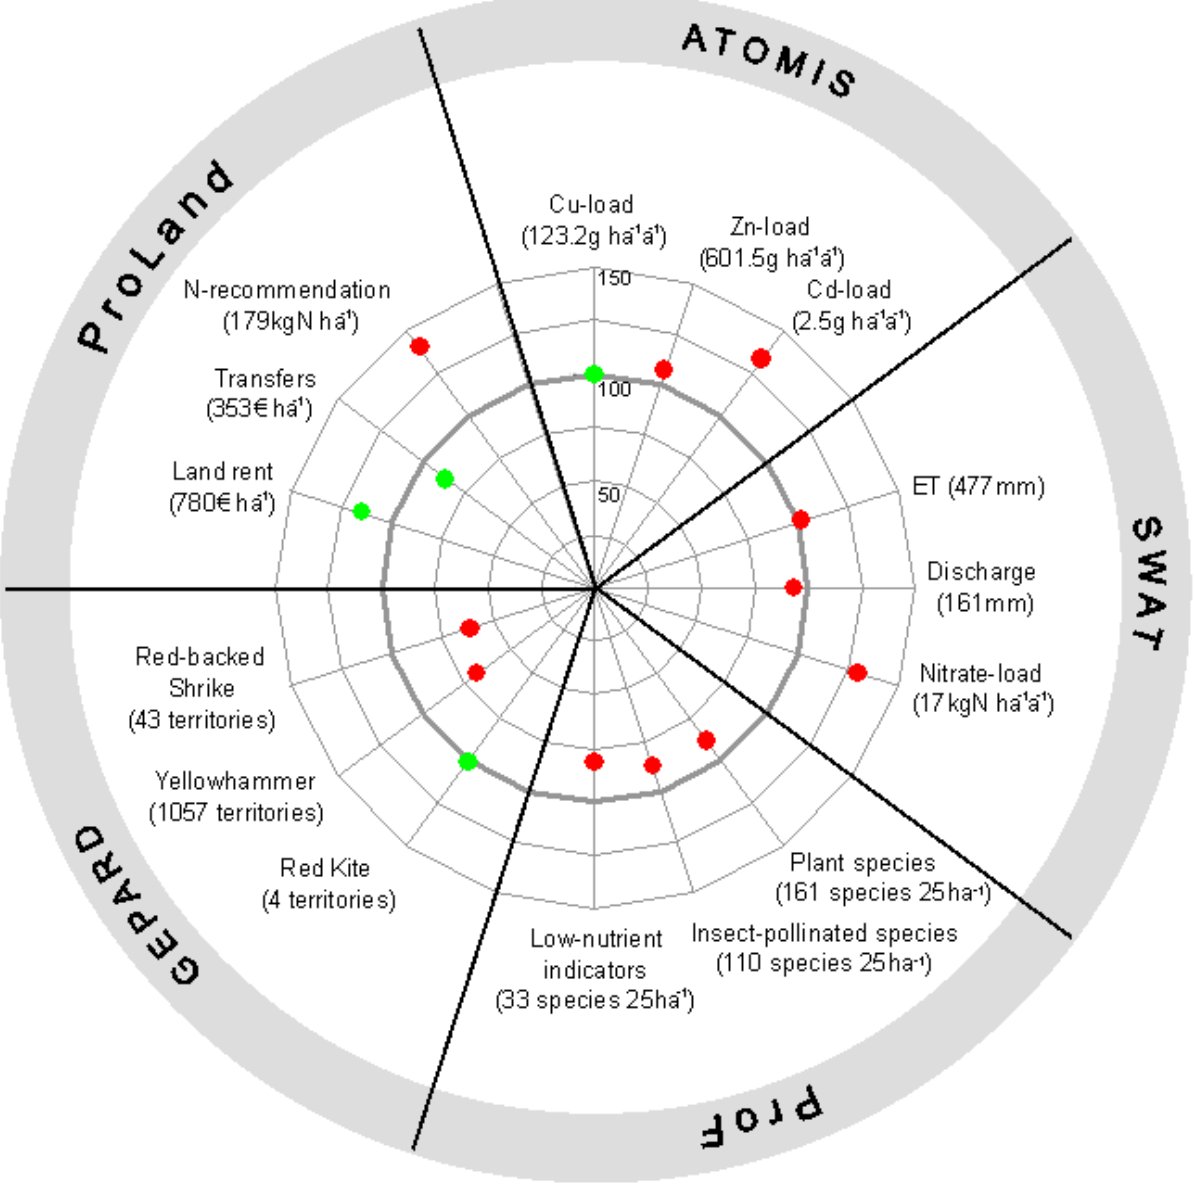
Fig. 3 . Integrated evaluation of today's landscape at the scale of the entire study region. Shown are indicator values of the BS in percent of the MS indicator values. Red (green) dots: Negative (Positive) evaluation of the BS in comparison to the MS. The estimated MS indicator values are given in brackets as mean/reference unit or total values. ET,